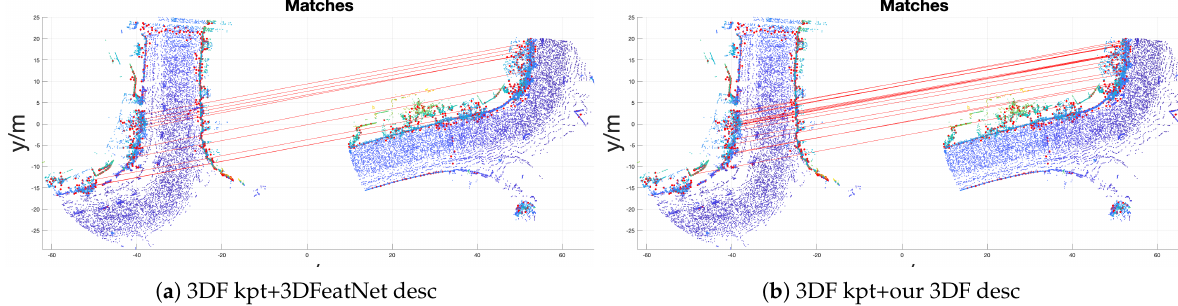
Figure 4. Oxford data geometric registration success sample. Keypoints are plotted with red dots on the point cloud. Red lines represent the matching between